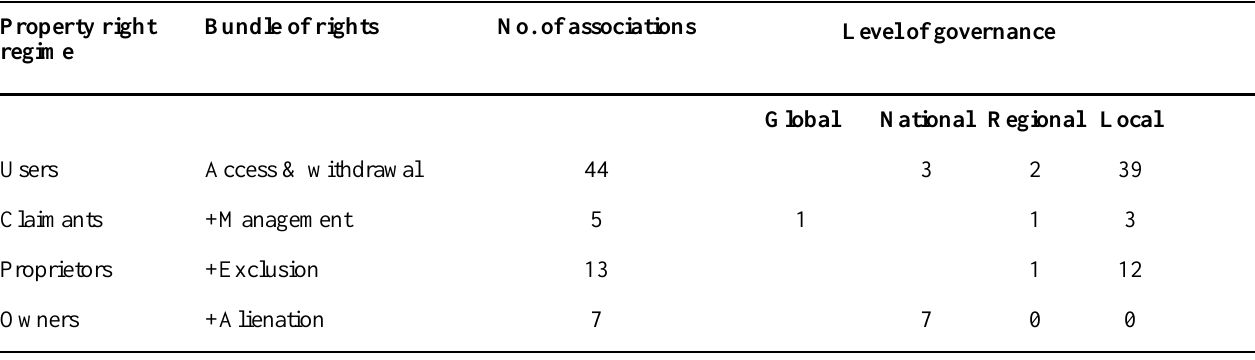
Table 4 . Property right regimes, bundle of rights, and level of governance among local stewardship associations active in the Park Property right Bundle of rights No. of associations Level of governance regime Global National Regional Local Users Access & withdrawal 44 3 2 39 Claimants +Management